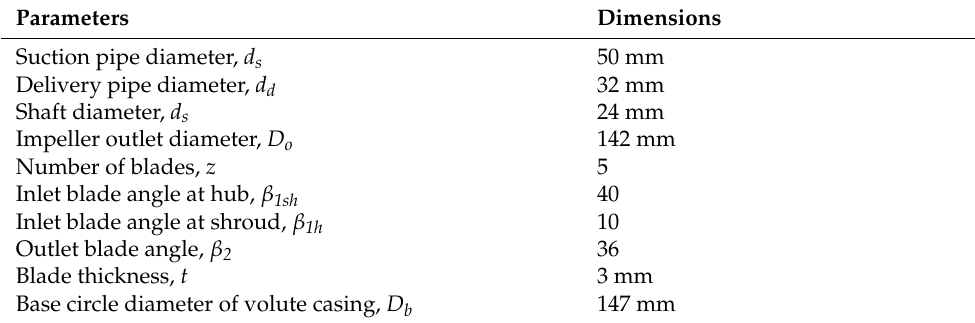
Table 2. Reference pump dimensions.